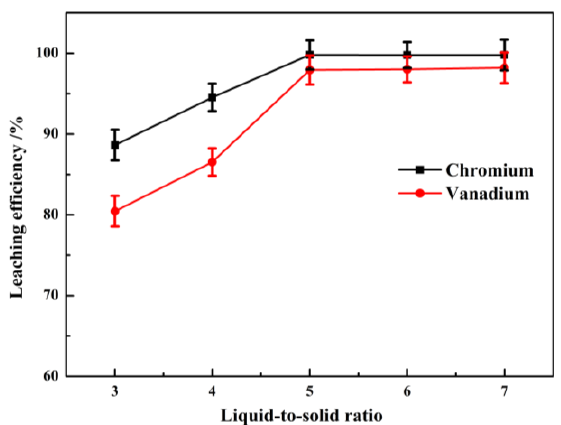
Figure 8. Effect of liquid-to-solid ratio on the leaching efficiency of vanadium. Figure 8. E ff ect of liquid-to-solid ratio on the leaching e ffi ciency of